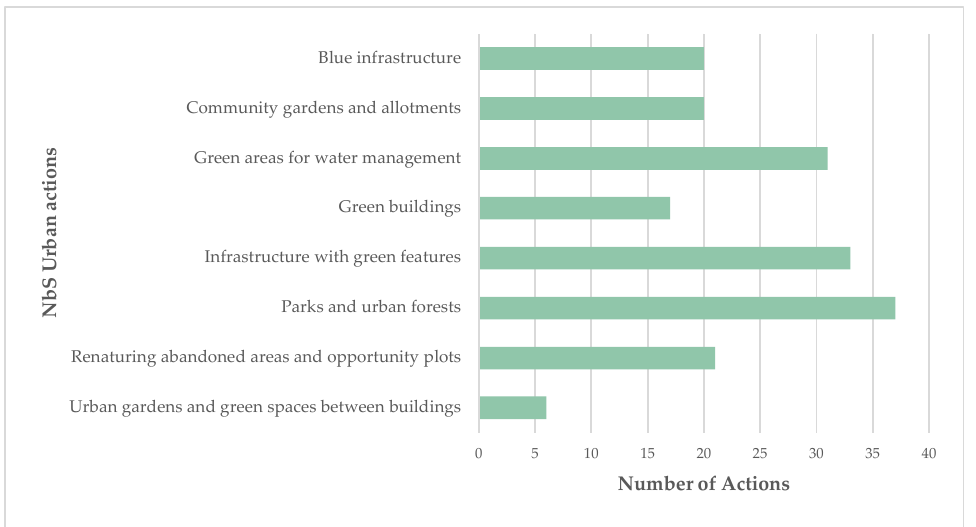
Figure 4. Distribution of NbS urban actions.